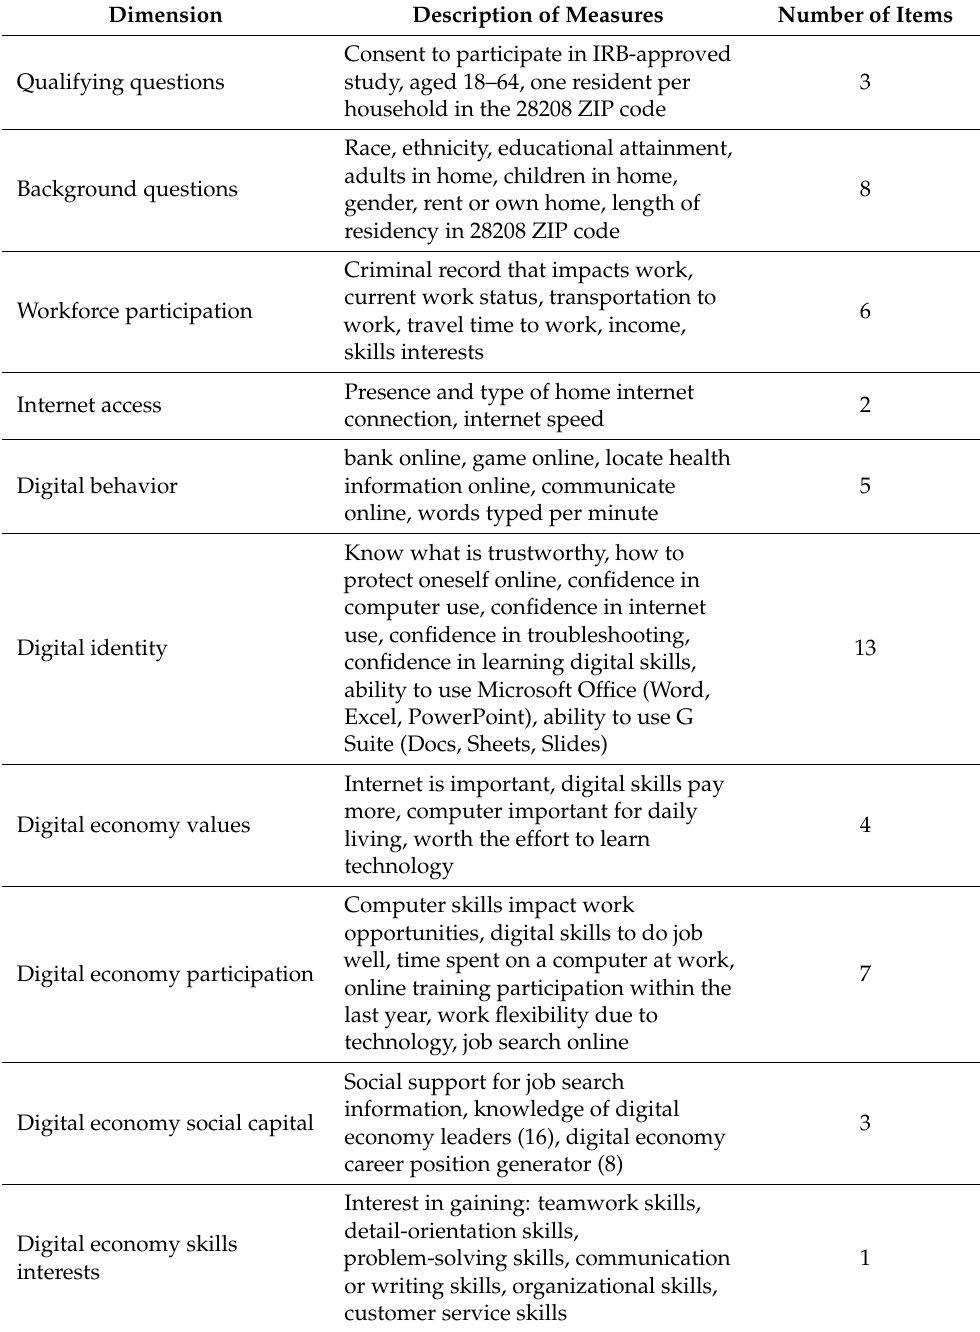
Table 1. Description of DEEKA Survey Tool